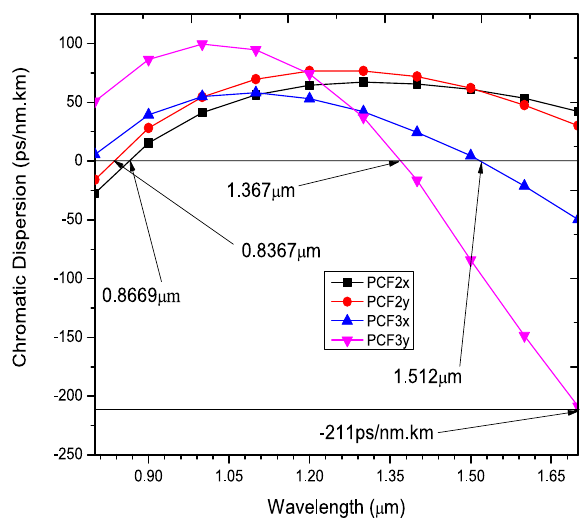
Fig. 10 Change of Chromatic dispersion as a function of wavelength for PCF2 and